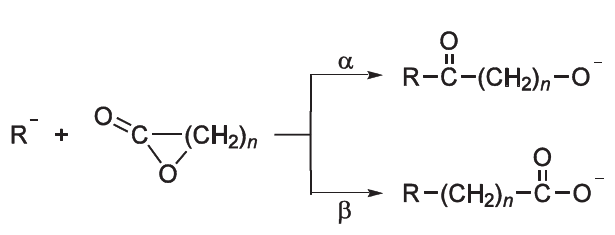
Figure 40. The AROP of lactones.